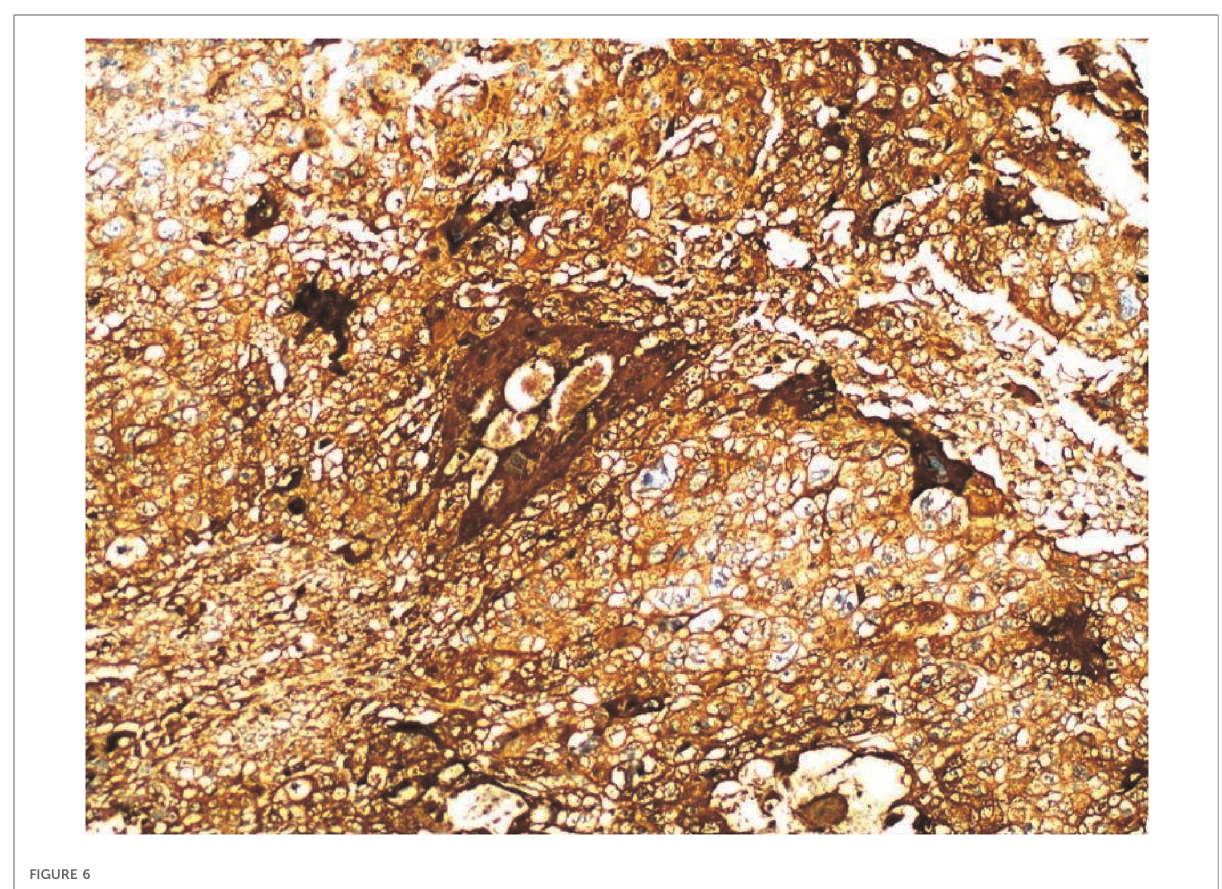
FIGURE 6 Immunohistochemistry: HCG(+) (SP